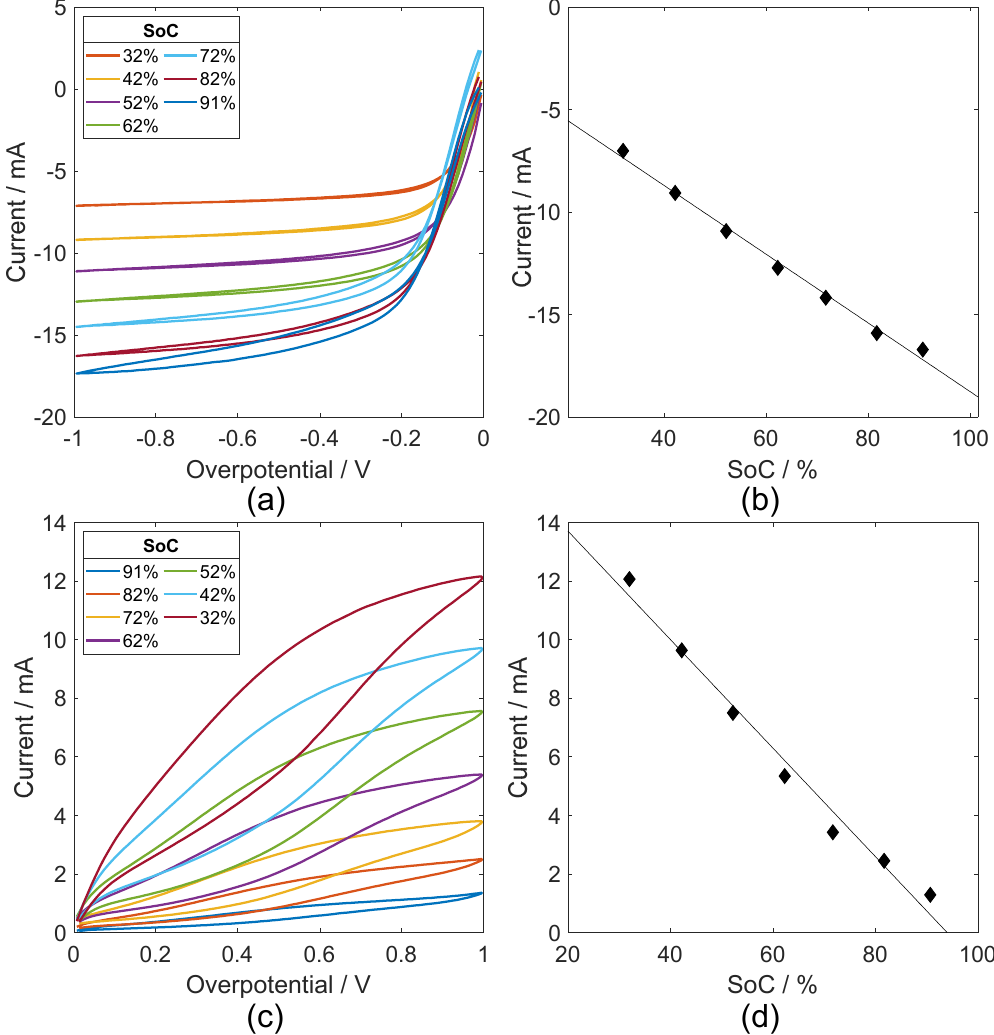
Figure 2. Results of cyclic voltammetry (CV) measurements with glassy carbon rotating disc electrodes (RDE) in positive electrolyte with different states of charge (SoCs), reduction current curves ( a ), reduction current values versus SoC ( b ), oxidation current curves ( c ), oxidation current values versus SoC ( d ) (scan rate 20 mV/s, platinum pseudo reference, diameter active area 5 mm).